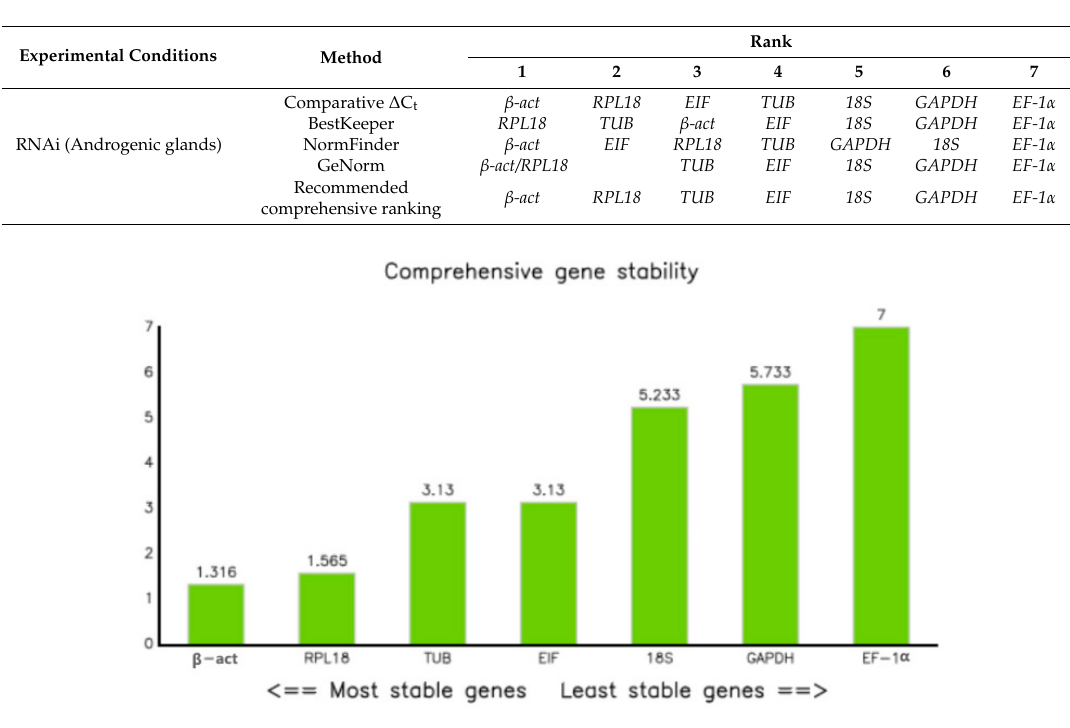
Figure 6. Comprehensive ranking of reference genes of RNAi.